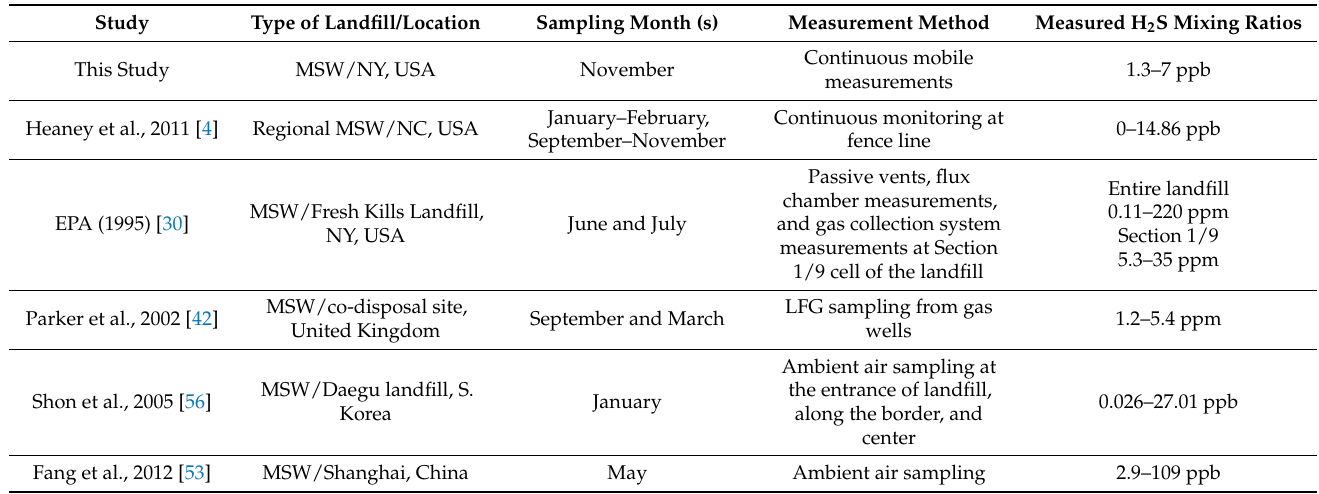
Table 2. H 2 S emission flux estimates from this study compared to previous